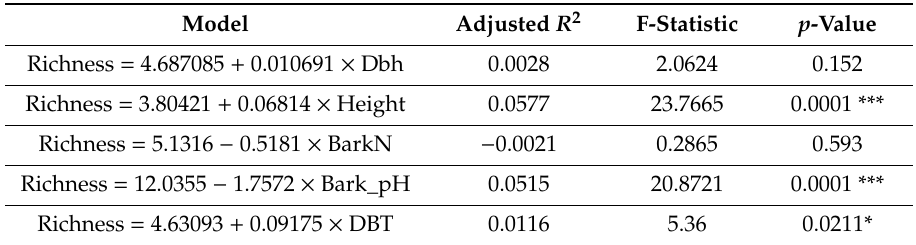
Figure 5. Pearson pairwise correlation analysis between epiphytic lichen species diversity and tree properties. Table 4. The linear regression model parameters between tree properties and lichen